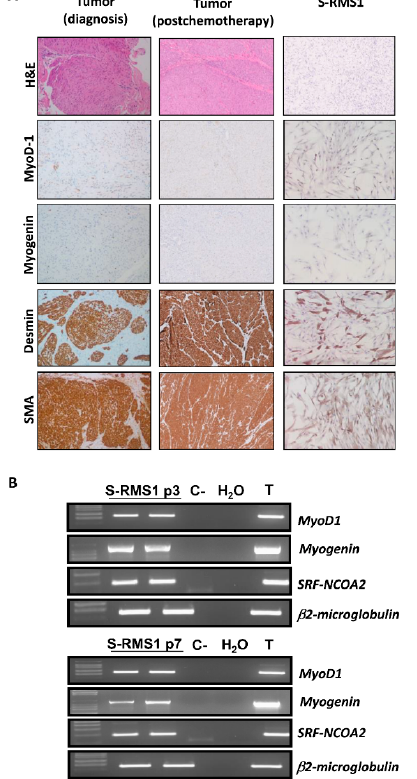
Figure 1. Establishment of S-RMS1 cell line. ( A ) IHC characterization of tumor at diagnosis, post- chemotherapy, and S-RMS1 cell line. S-RMS1 cell line showed positivity for MyoD-1, myogenin, desmin and smooth muscle actin (alpha-SMA) (magnification 20 × ), such as primary tumor pre- and postchemotherapy. Comparison of S-RMS1 morphology with RD18 and RH30. ( B ) Identifi- cation of fusion transcript SRF-NCOA2 in S-RMS1 at two different passages (p3 and p7). Reverse transcriptase polymerase chain reaction detection of MyoD1 (264 bp), myogenin, and SRF-NCOA2 chimeric transcript (93 bp). β 2-microglobulin was used for normalization. cDNA obtained from patient primary tumor (T) was used as positive control whereas cDNA from T lymphoblastoid CEM cell line (C-) was taken as negative